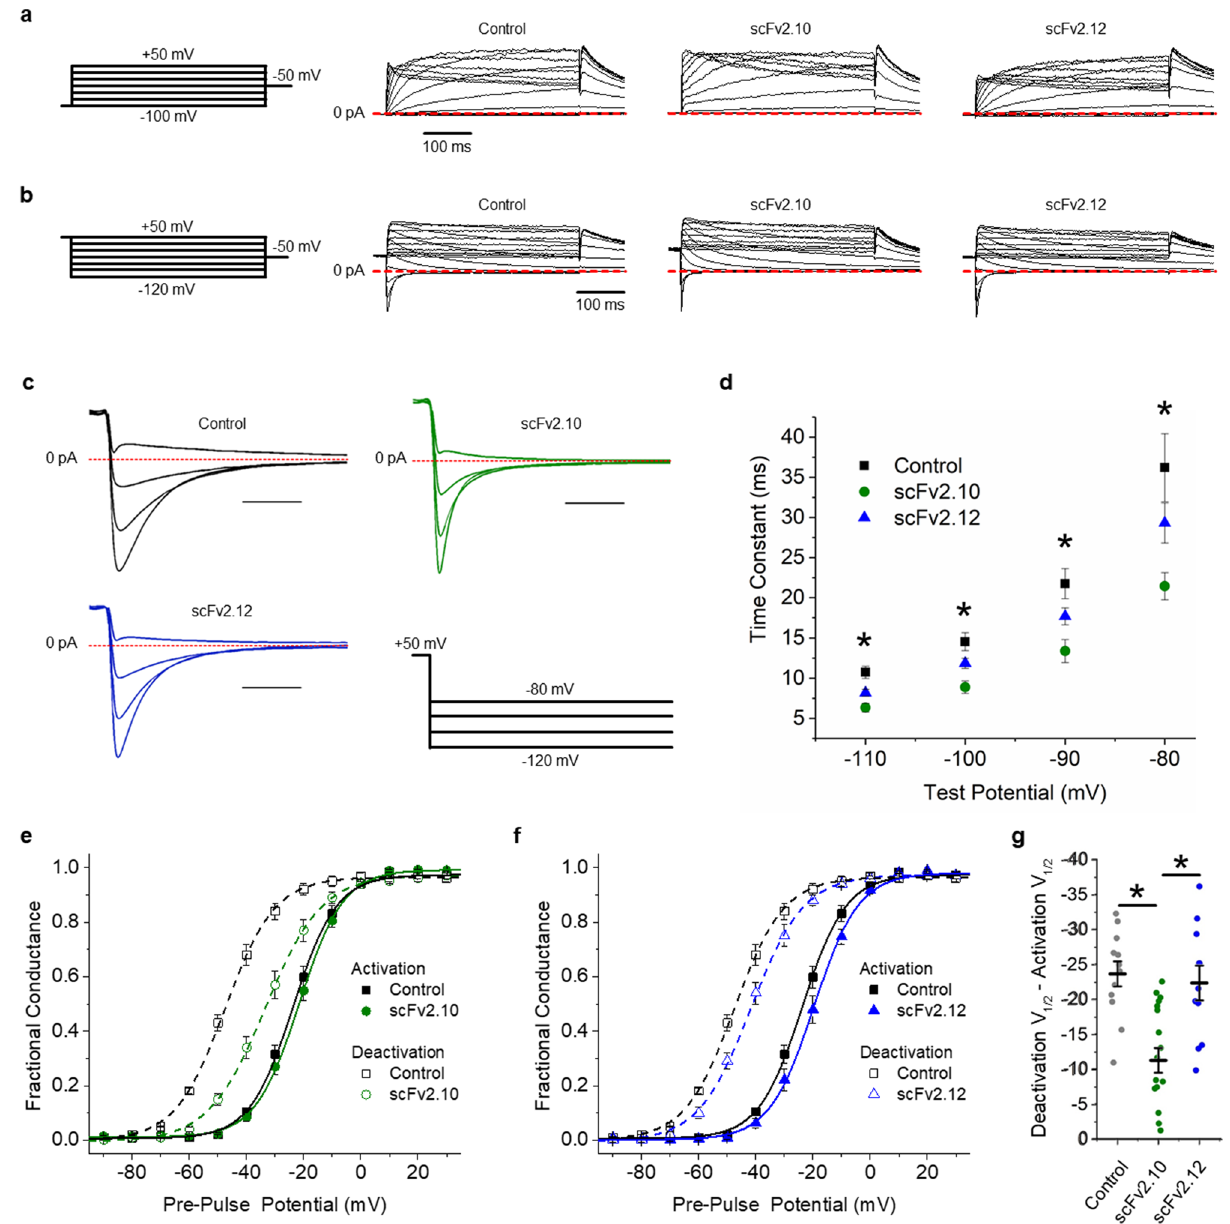
Figure 5. Effects of anti-PAS antibodies on hERG 1a ionic current hysteresis. ( a ) Pulse protocol (left) and corresponding sample ionic traces showing hERG 1a activation in vehicle control solution or in the presence of 10 µM scFv2.10 or 10 µM scFv2.12. ( b ) Pulse protocol (left) and corresponding sample ionic traces showing hERG 1a deactivation in vehicle control solution or in the presence of scFv2.10 or scFv2.12. ( c ) scFv2.10 modification of hERG 1a voltage dependence. Normalized peak tail current, representing fractional conductance, is plotted as a function of pre-pulse potential and fitted with a Boltzmann function for hERG 1a recordings in vehicle control solution (black) and scFv2.10 (green). ( d ) scFv2.12 modification of hERG 1a voltage dependence. Normalized peak tail current, representing fractional conductance, is plotted as a function of pre-pulse potential and fitted with a Boltzmann function for hERG 1a recordings in vehicle control solution (black) and scFv2.12 (blue). ( e ) The magnitude of hysteresis was quantified by subtracting the V 1/2 of deactivation from the V 1/2 of activation. Hysteresis was significantly smaller in the presence of scFv2.10 ( n = 14) compared with control recordings ( n = 12) and recordings in the presence of scFv2.12 ( n = 6). ( f ) Expanded view of deactivating hERG 1a ionic currents recorded from Control (black), scFv2.10 (green) and scFv2.12 (blue) cells. ( g ) Fast time constants of deactivation plotted as a function of test potential for Control (black), scFv2.10 (green) and scFv2.12 (blue) cells. Time constants were derived by fitting current decay with a double exponential function. All data are reported as mean ± SEM. * indicates p <